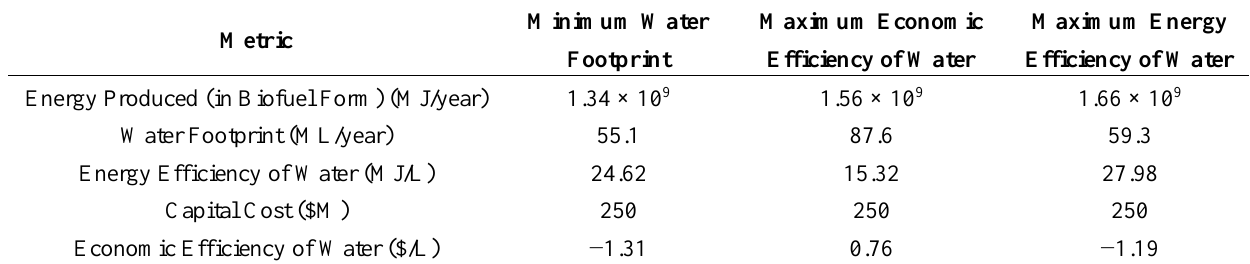
Table 3. Compilation of results for the three optimization